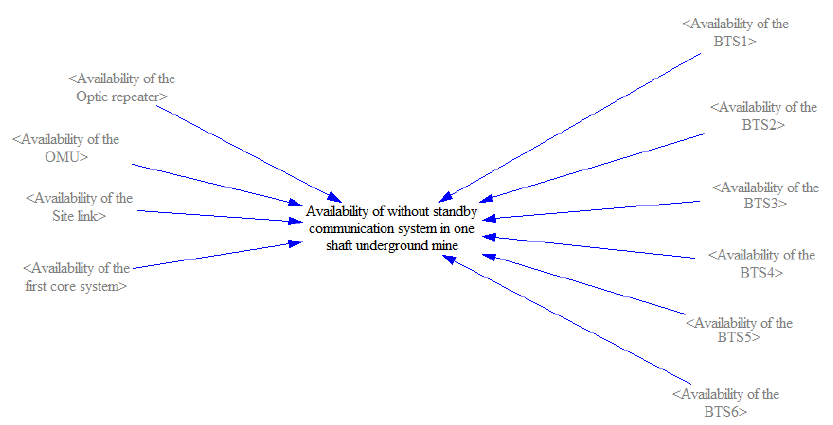
Figure 5. Site link model.